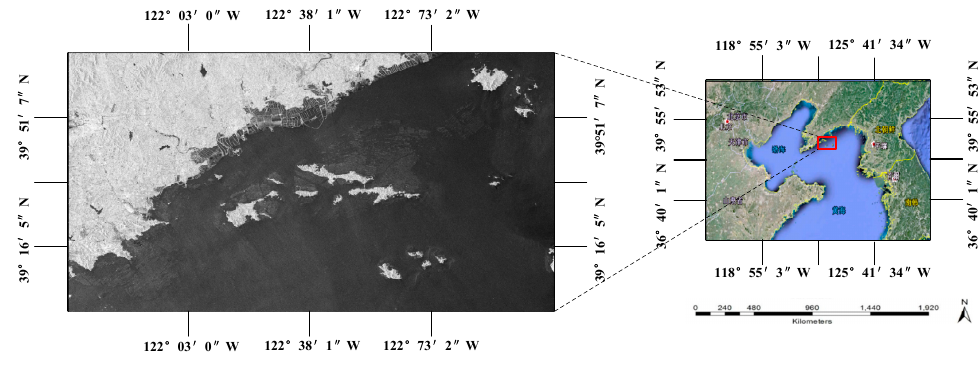
Figure 11. Study Figure 11. Study area.